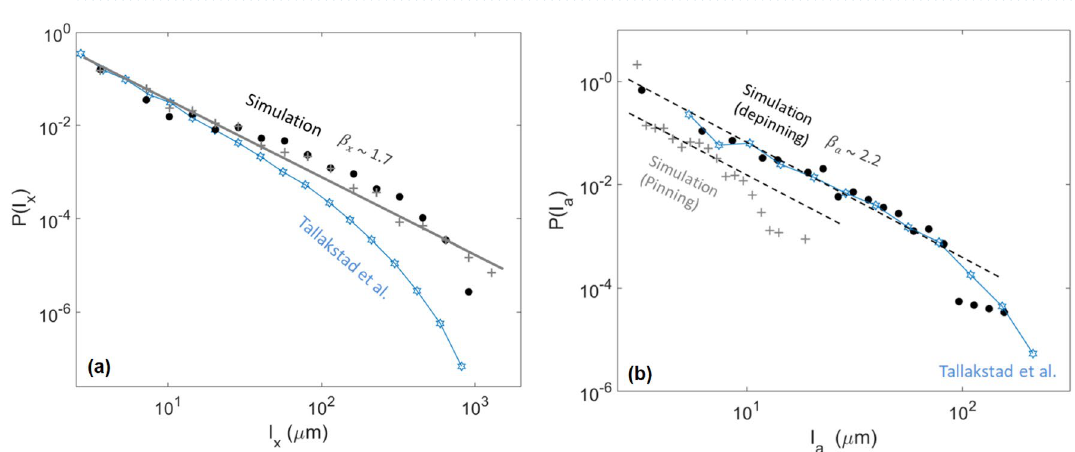
Figure 9. ( a ) Probability density function of the crossline extent l x of the modelled avalanche clusters (plain points) and of the modelled pinning clusters (crosses), for a threshold c = 3 . The straight line has a slope β x = 1.7 , as per Eq. (13). The hollow stars shows the experimental probability density function obtained by Tallakstad et al. 28 for the pinning and avalanche clusters (from their Fig. 16a, inset, c = 3). ( b ) Probability density function of the inline extent l a of the modelled avalanche clusters (plain points) and of the modelled pinning clusters (crosses), for a threshold c = 3 . The two straight dashed lines have a slope β x = 2.2 , inline with that of the experimental data from Tallakstad et al. 28 for the pinning clusters (hollow stars, from their Fig. 16b, inset, c =